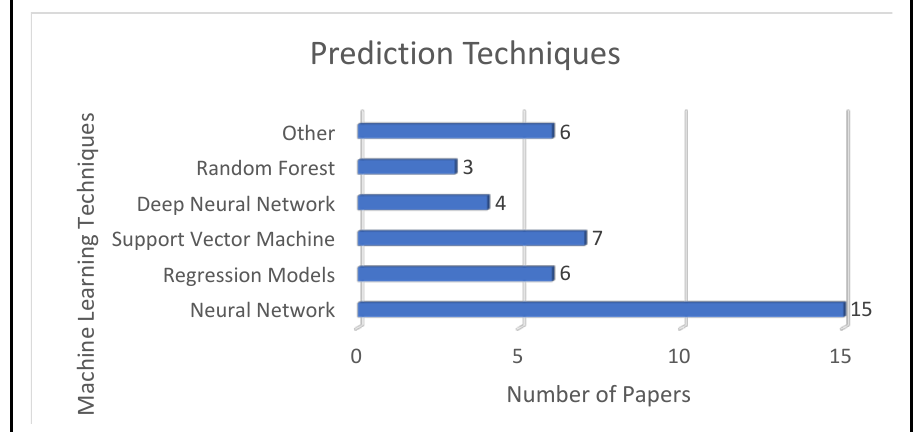
Figure 14. Top classification techniques identified in our survey.